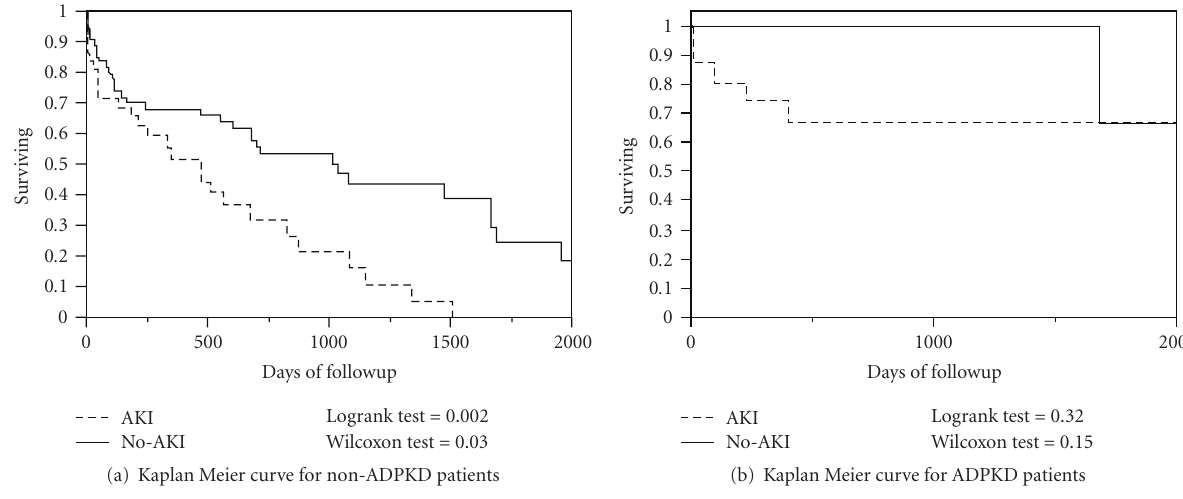
Figure 1: Survival analysis of non-ADPKD patients (a) and ADPKD patients (b) with no AKI versus